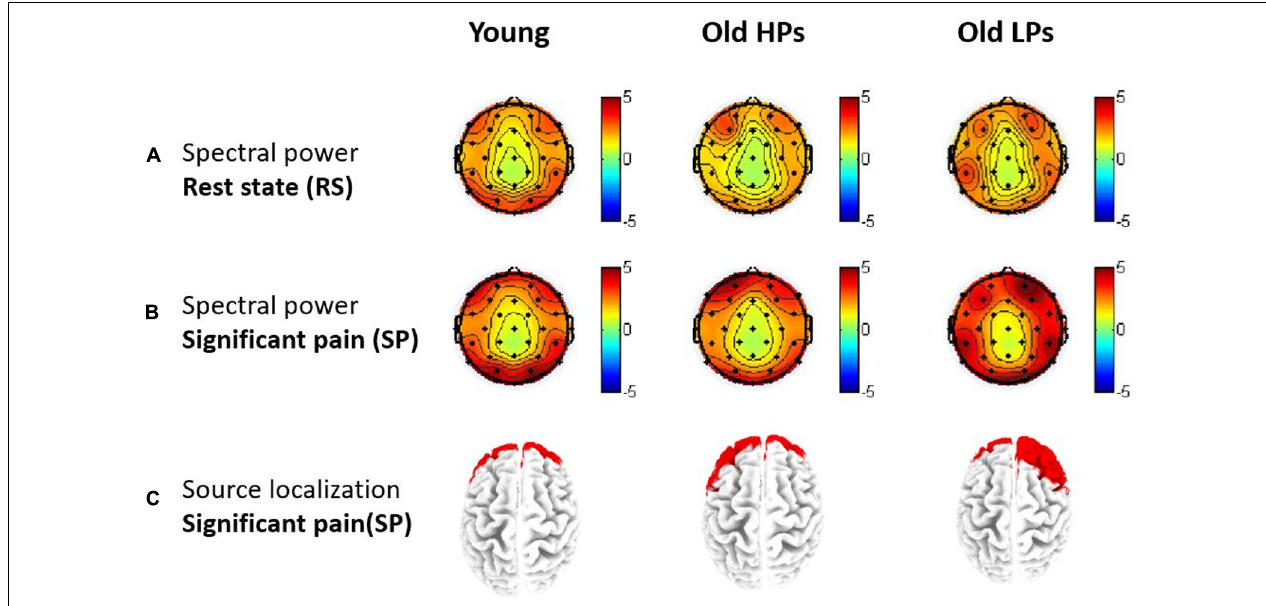
FIGURE 4 | Topographies of gamma-band oscillations (GBOs). (A) Spectral power maps during resting-state and (B) significant tonic heat pain. (C) Source localization of areas with largest GBO power during significant tonic heat pain.